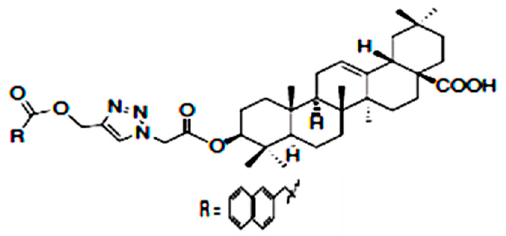
Figure 2. 3 β -{2-[4-(2-Naphthalen-1-yl)acetoxymethyl-1 H -1,2,3-triazol-1-yl]acetoxy}olean-12-en-28-oic acid (8 g) [64].